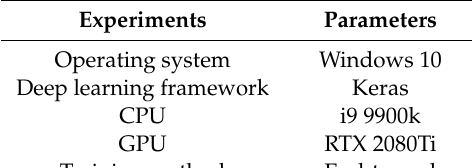
Table 3. Training parameters.